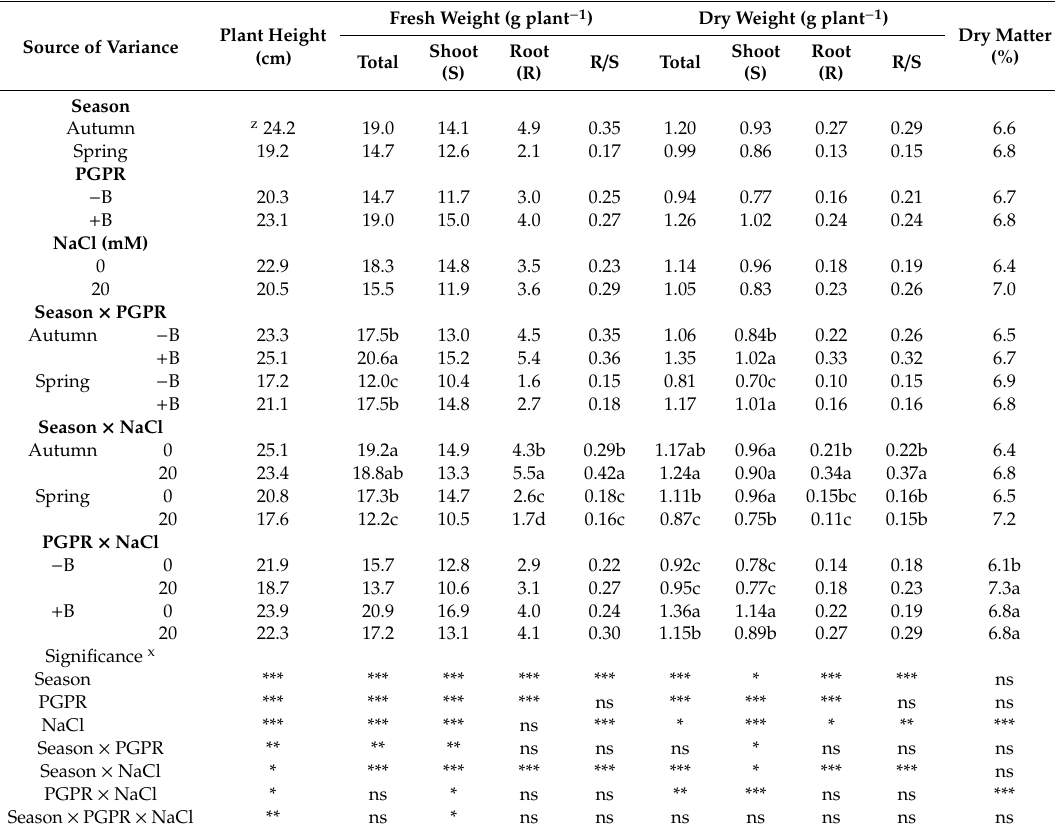
Table 1. Morphological parameters of leaf lettuce plants grown during autumn and spring in nutrient solutions containing di ff erent levels of NaCl and bacterial biostimulant.